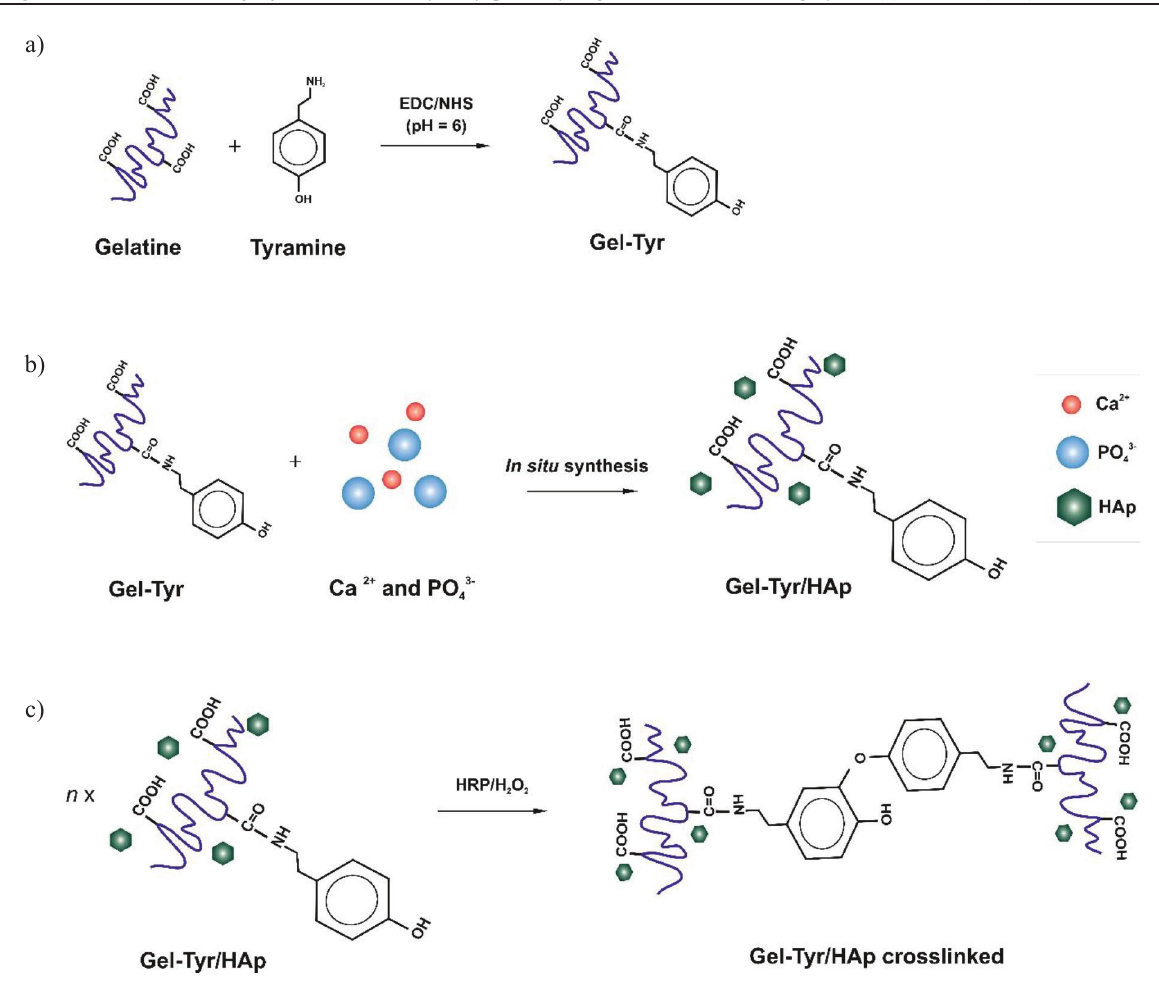
Fig. 1 – Illustration of hydrogel synthesis performed in three steps: a) tyramine grafting on carboxylic group of gelatine; b) in situ precipitation of hydroxyapatite within Gel-Tyr solution from calcium and phosphate precursors; c) enzymatic crosslinking of Gel-Tyr/HAp composite using horseradish peroxidase with hydrogen